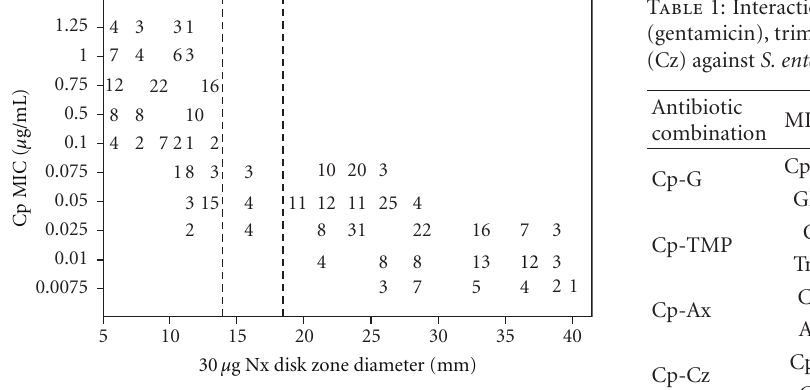
Figure 2: Scattergram plotting the minimum inhibitory concentra- tion (MIC) values of ciprofloxacin (Cp) and zone diameter of inhi- bition (ZDI) around 30 μ g nalidixic acid (Nx) disc for 421 S. Typhi isolates processed by the NCCLS methods. The broken vertical lines represent interpretative ZDI suggested for Enterobacteriaceae (susceptible at ≥ 19mm, resistant at ≤ 13mm). The numbers within the graphic indicate the number of S. Typhi isolates.